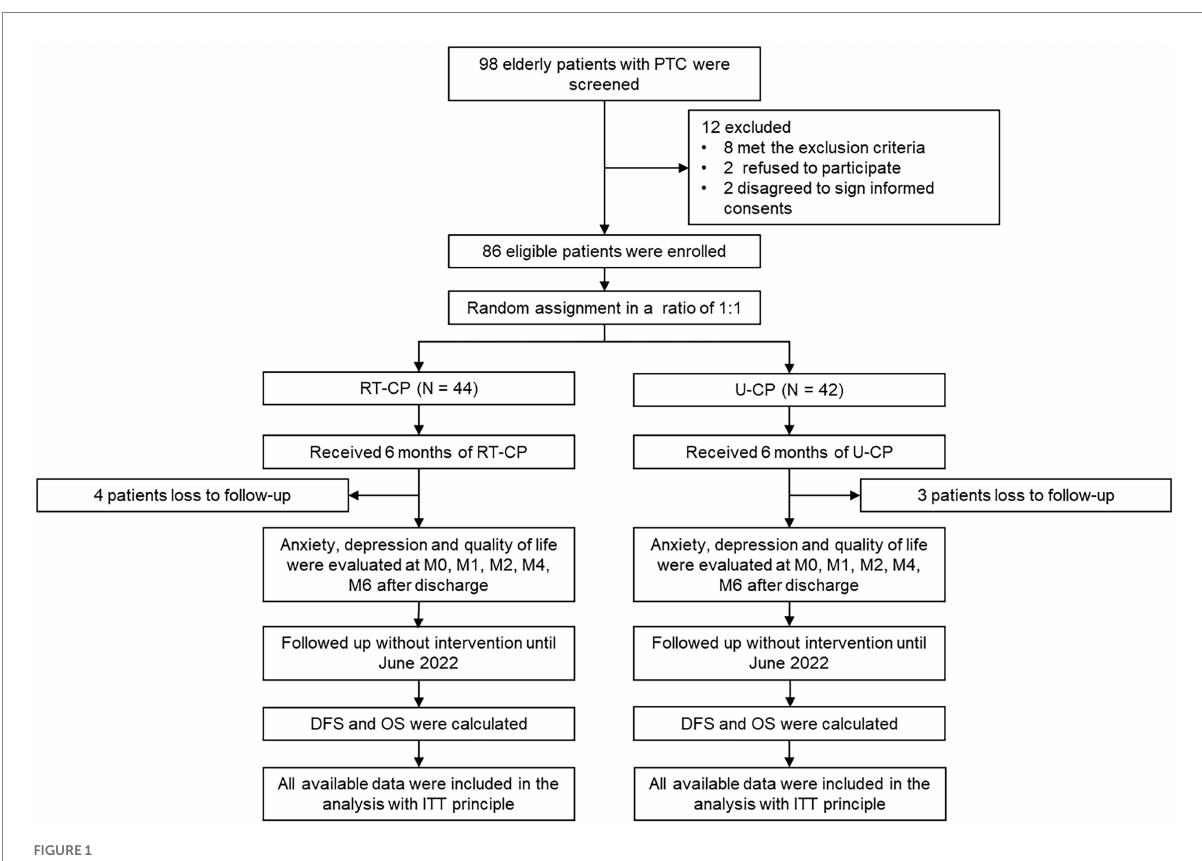
FIGURE 1 Study flow